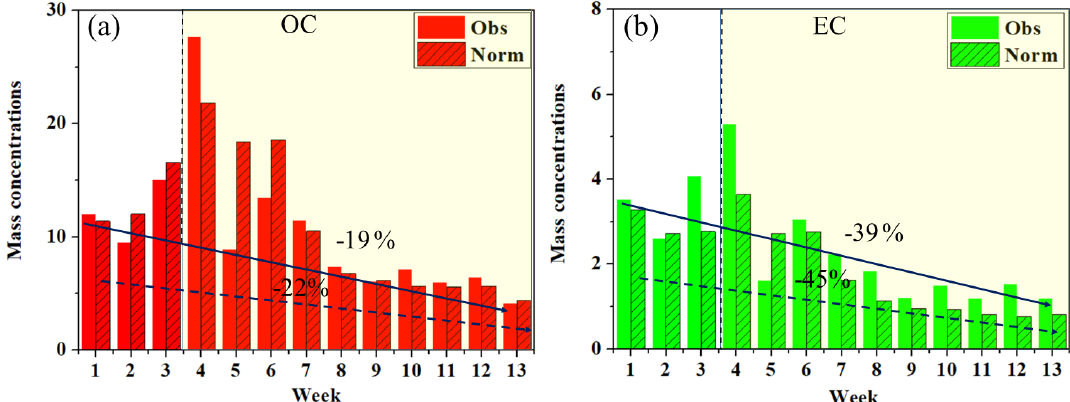
Figure 5. Observed and deweathered weekly concentrations and changes in organic carbon (OC) and elemental carbon (EC) during 1 January–31 March. The solid black line and dotted line represent the decrease ratio of observed concentration and simulated concen- tration from pre-COVID to post-COVID, respectively. The white background denotes the changes in gaseous pollutants before COVID-19, while the faint yellow one represents the chemical components after the COVID-19